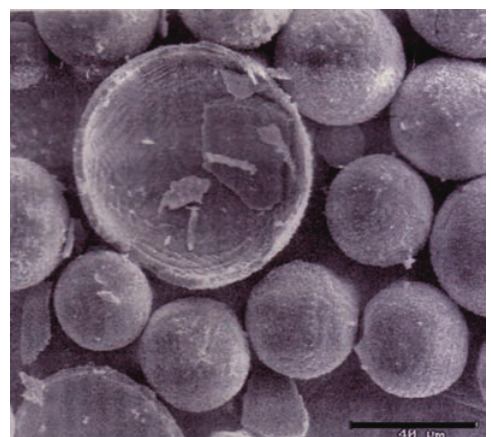
Fig. 10 TEM image of hollow particles prepared by spray pyrolysis 137) . Scale bar is 1 μ